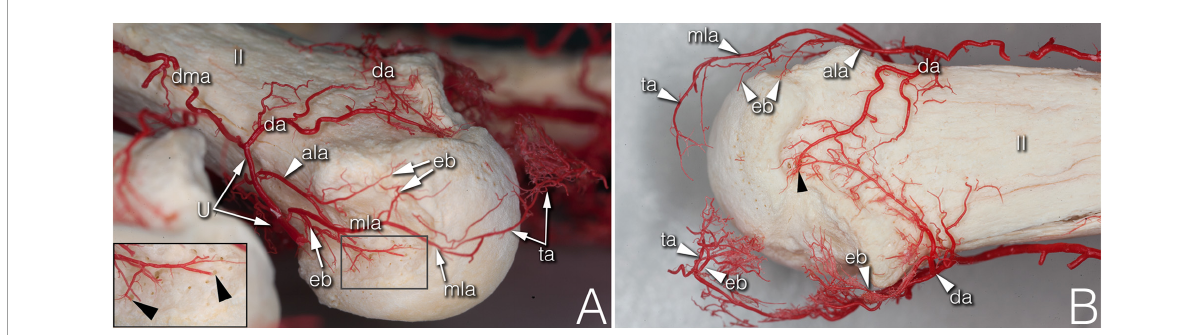
FIGURE2 Supplying branches to the metacarpal territory on corrosion cast specimens. (A) (right hand anterolateral view) A strong enthesial branch arises directly from the first part of the main lateral artery and gives off branches running toward the nutrient foramina of the lateral depression (see insert). Both the upper accessory lateral artery and the main lateral artery give off one further enthesial branch to the upper part of the lateral depression. The main lateral artery curves to and terminates at the projection of the triangular arcade. (B) (upper view of the same specimen) Note the spiky character of the ulnar sided enthesial branches (top of image), while radially (bottom of image) both the enthesial branch and the triangular arcade artery demonstrate a bushy appearance. ala, accessory lateral artery; da, dorsal arcade; dma, dorsal metacarpal artery; eb,